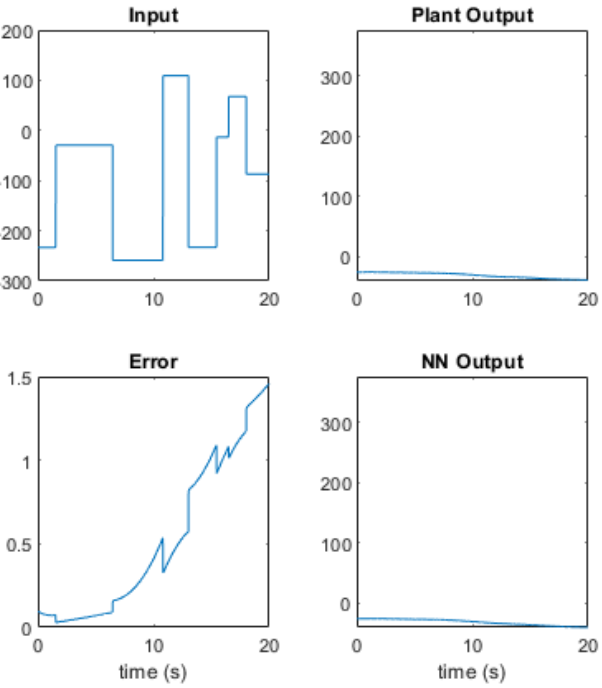
Figure 24. Neural model testing data.